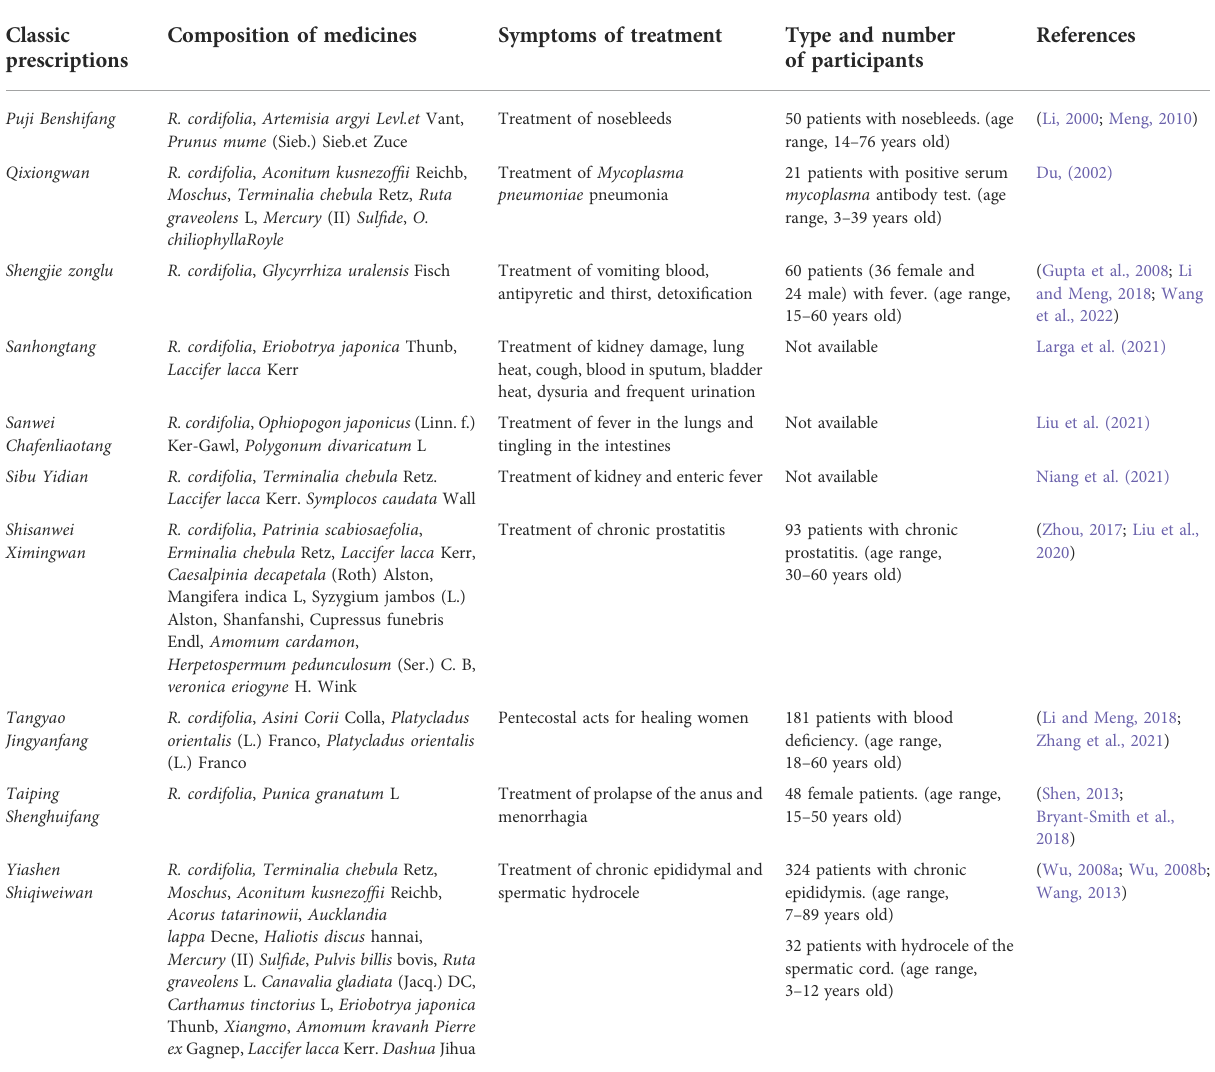
TABLE 1 Clinical application of R. cordifolia in traditional